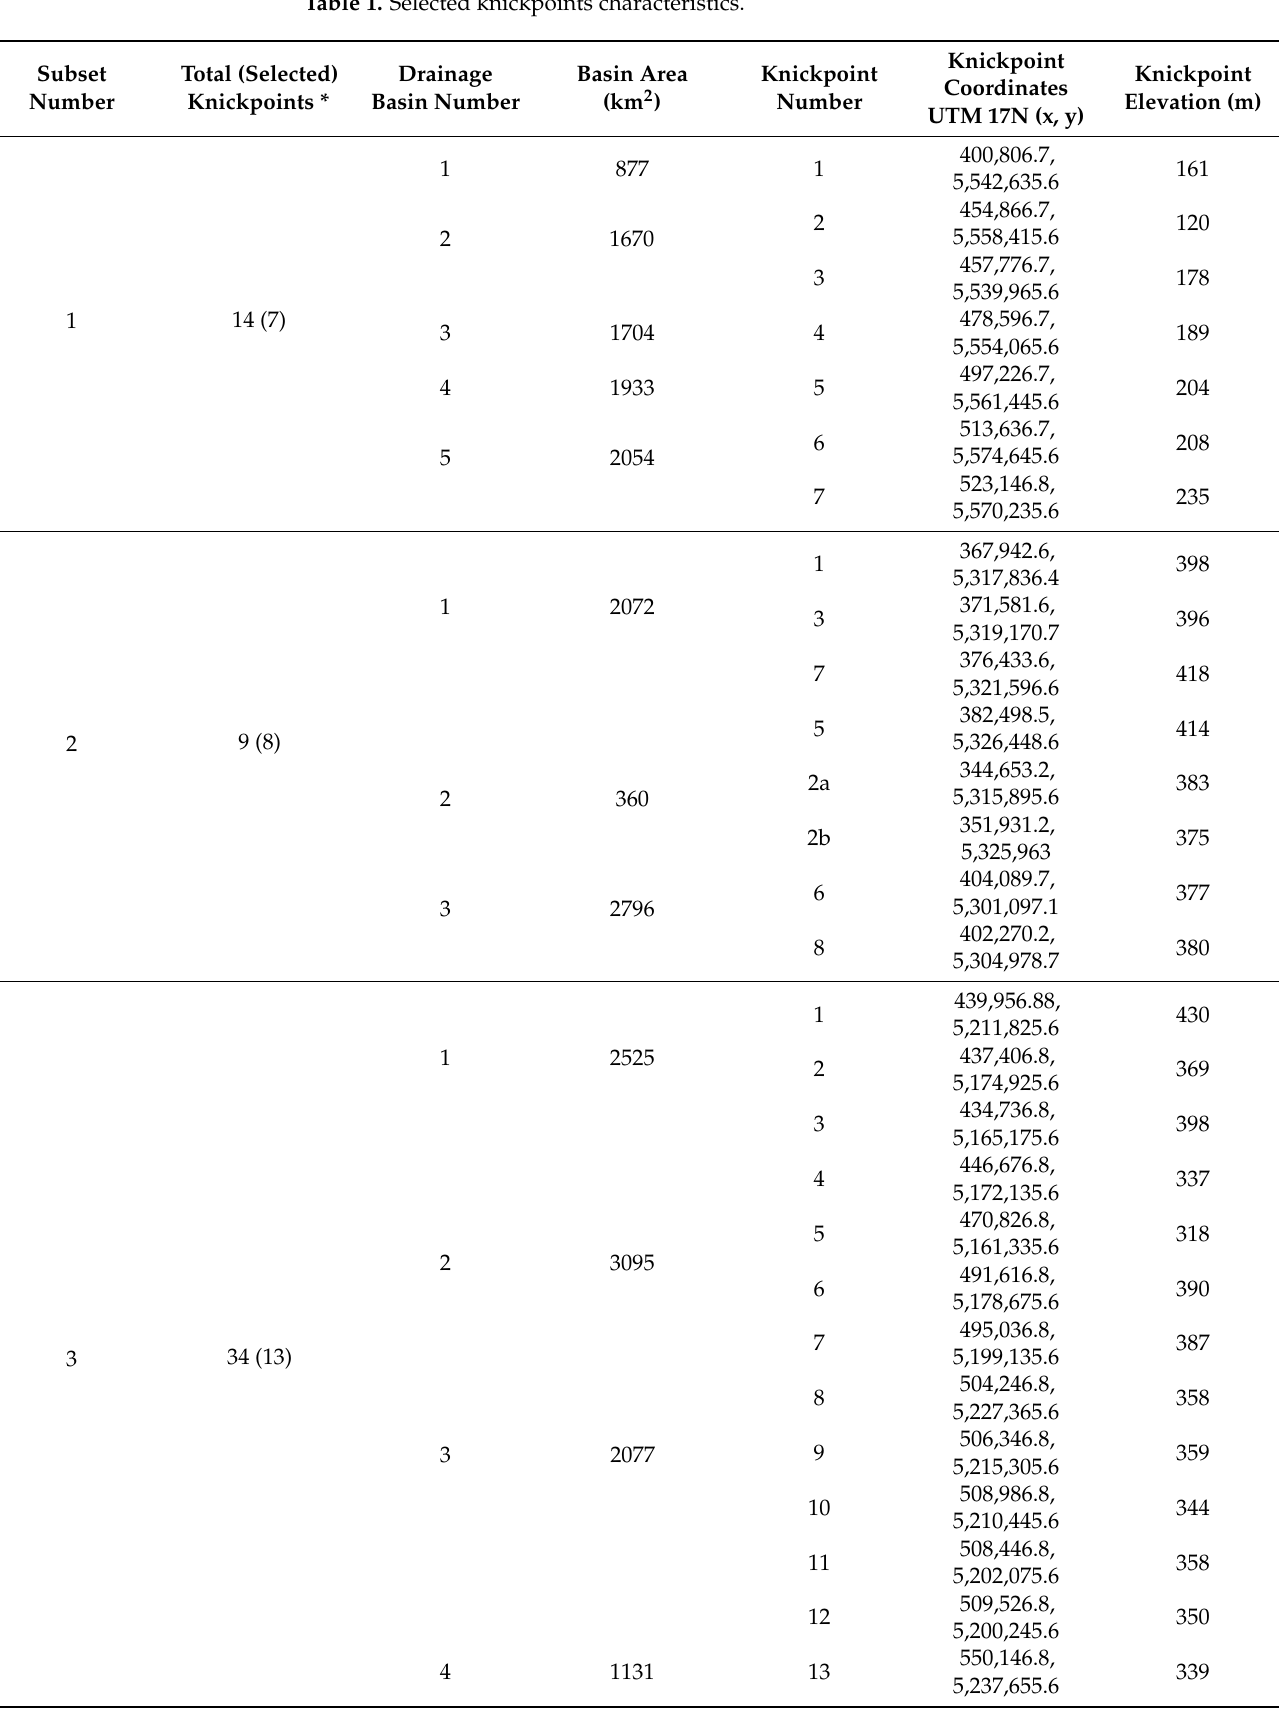
Table 1. Selected knickpoints